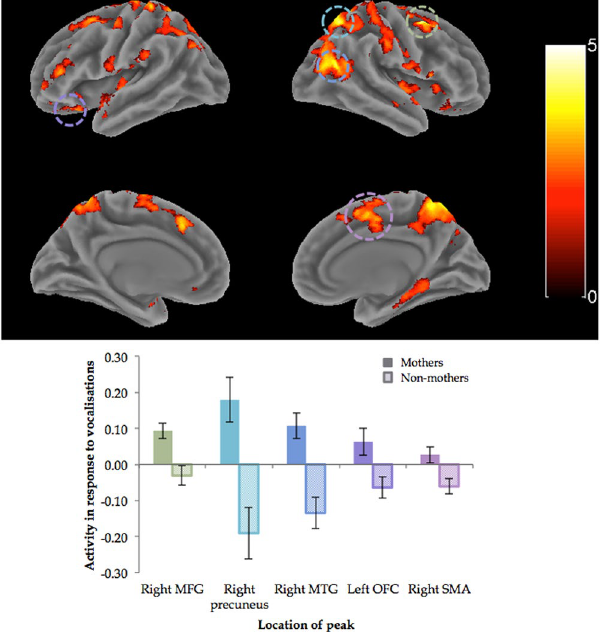
Figure 1. Contrasting brain activity in mothers and non-mothers: Mothers demonstrated greater reactivity to vocalisations from infants and adults across a range of cortical regions implicated in the processing of affective auditory cues. These regions included areas involved in executive functions and higher order cognitive functions (middle frontal gyrus; MFG; precuneus) 56 , interpretation of vocal content (middle temporal gyrus, MTG), affective processing (orbitofrontal cortex, OFC) and preparatory motor responses (supplementary motor area, SMA). [Upper: whole brain images are displayed with a p < 0.03, FWE-cluster corrected for multiple comparisons for ease of visualisation; Lower: parameter estimates were extracted from 6 mm radius spheres centered on peak coordinates identified in the whole brain GLM. Error bars represent mean + / − standard error].